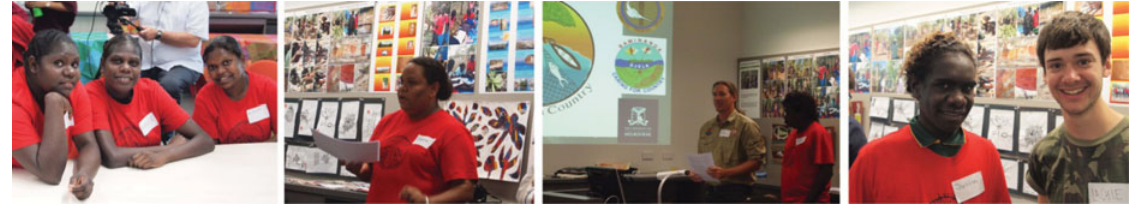
(Colour online) The participatory workshop. understandingoftheircountryandcommunity . . .